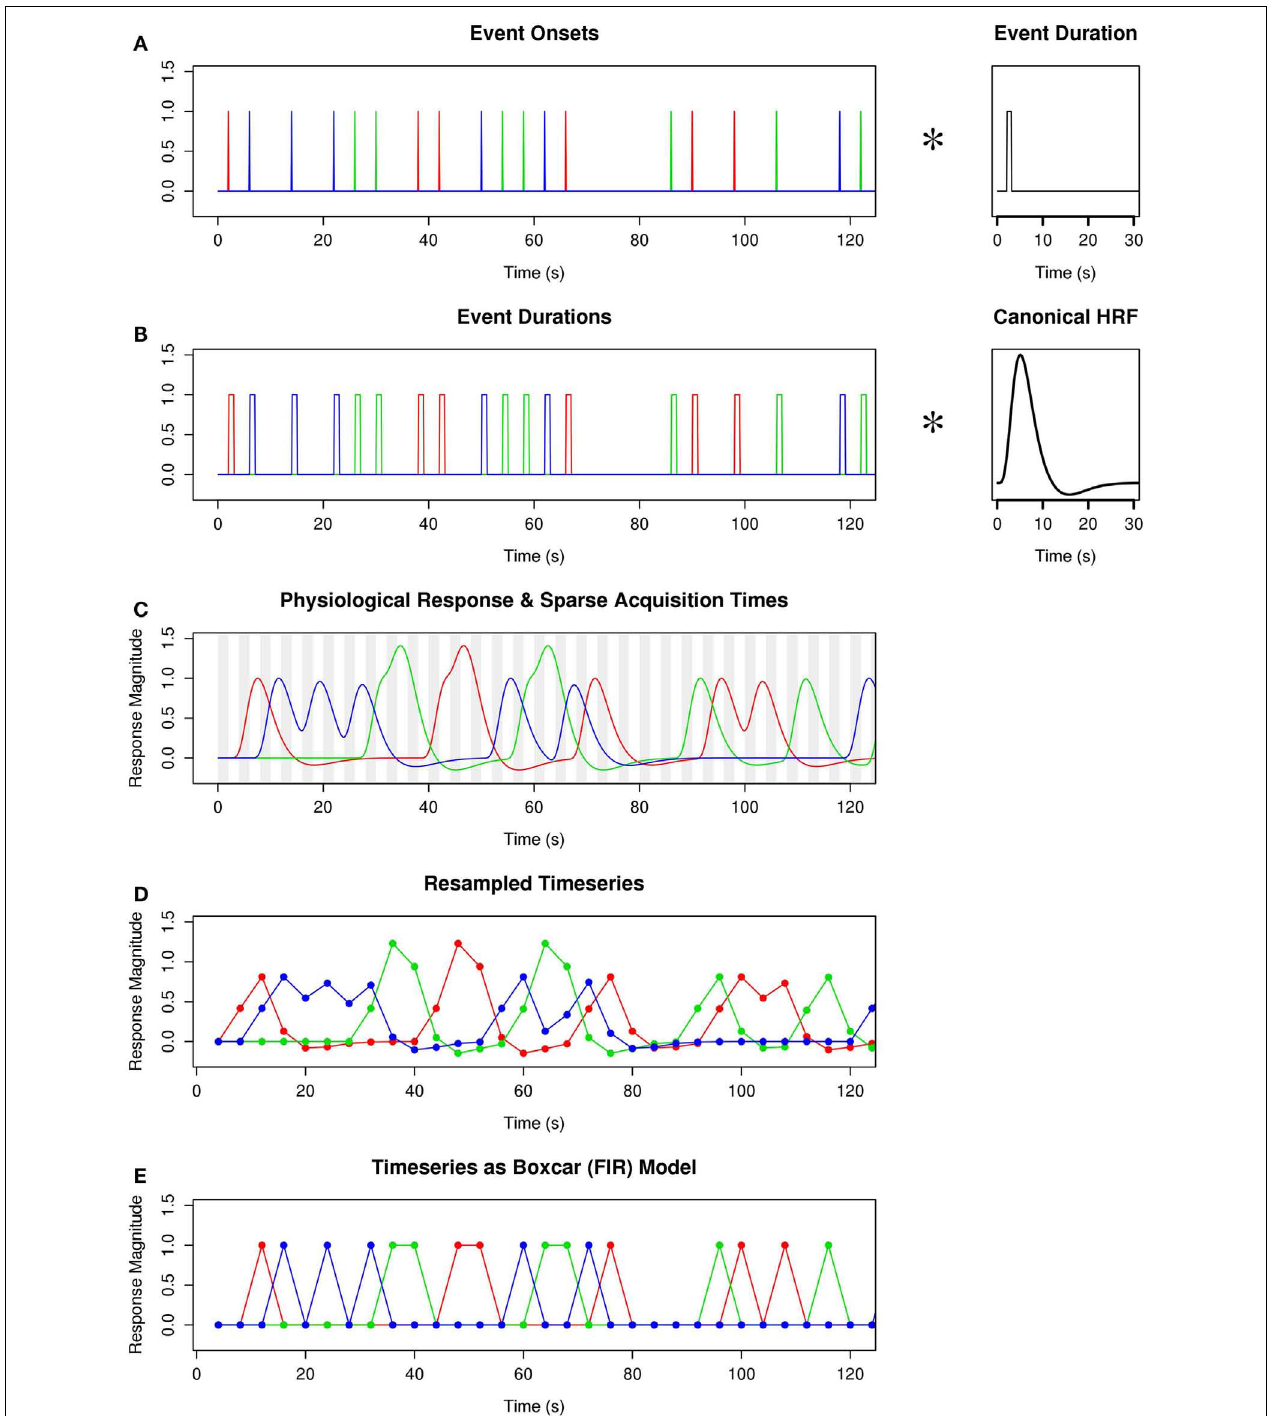
series can be scaled and demeaned for use in the design matrix of the general linear model. (E) The same sparse time series is shown with classical boxcar (FIR) modeling, illustrating the greater information in the HRF-convolved time series. Figure legend: colored traces (red, green, blue) depict different event types; vertical gray bars indicate time of MR signal acquisition;TR = 4s;TA = 2s; ISI =